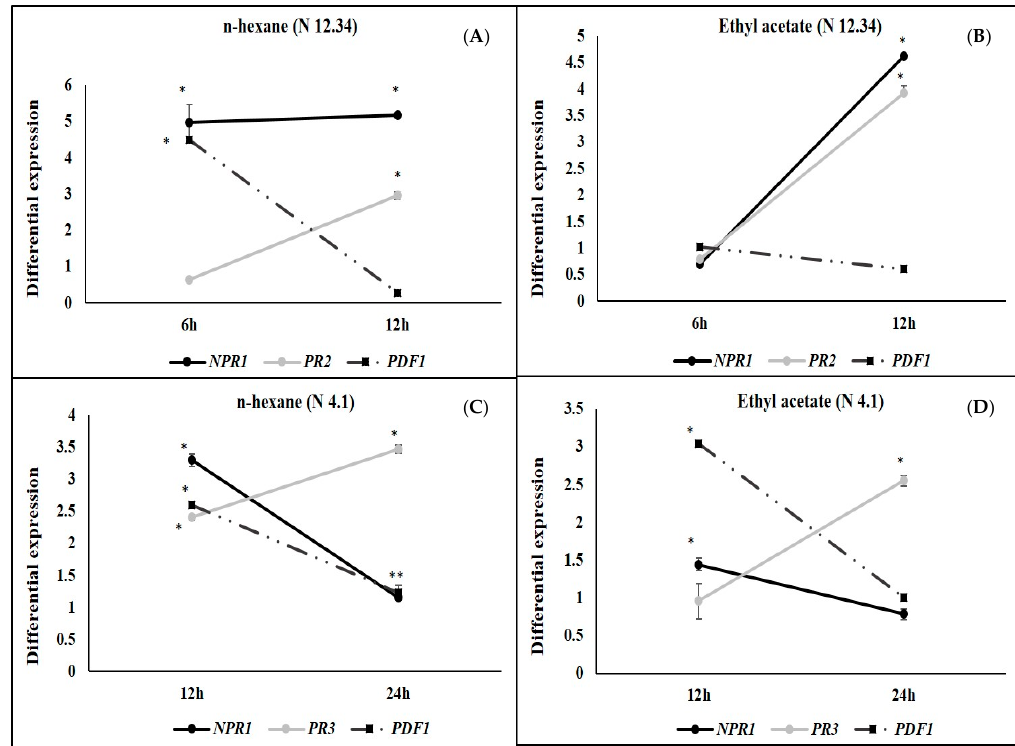
Figure 7. Differential gene expression in plants under the following treatments: ( A ) N 12.34 elicitors from the n-hexane fraction; ( B ) N 12.34 elicitors from the ethyl-acetate fraction; ( C ) N 4.1 elicitors from the n-hexane fraction; and ( D ) N 4.1 elicitors from the ethyl-acetate fraction vs negative control, at 6 ( n = 16) and 12 ( n = 16) hapc in N 12.34 ( A , B ), and at 12 ( n = 16) and 24 ( n = 16) hapc in N 4.1 ( C , D ). NPR1 and PR2 genes as markers of the SA signaling pathway and PDF1 as marker of the JA/ET signaling pathway in N 12.34; NPR1 as marker of the SA signaling pathway, and PDF1 and PR3 as markers of the JA/ET signaling pathway in N 4.1. Asterisks represent statistically significant differences ( p < 0.05) within each sampling time. Genes and sampling times were chosen based on results obtained by bacterial strains (Figures 4 and 6).